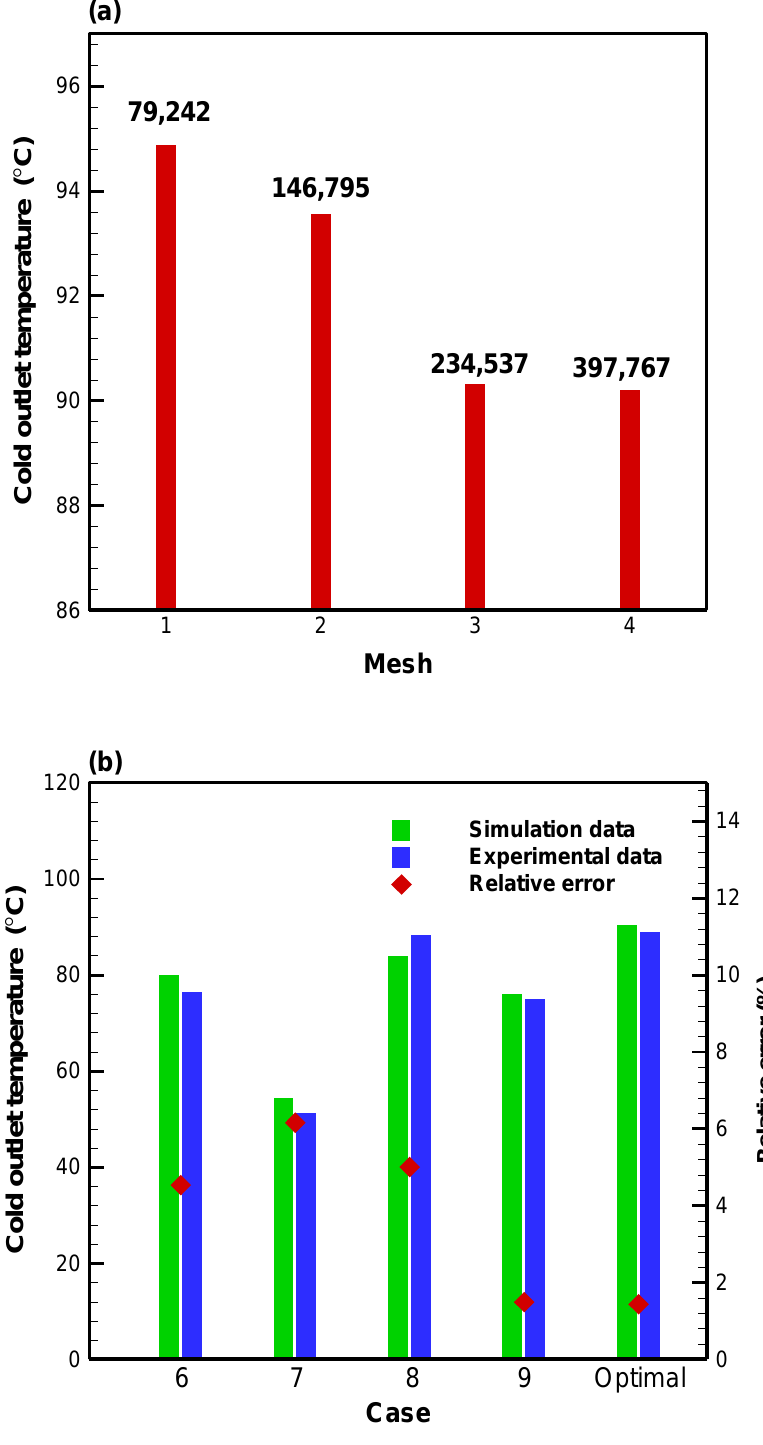
Figure 6. ( a ) Results of grid tests, and ( b ) comparisons of numerical and experimental results.